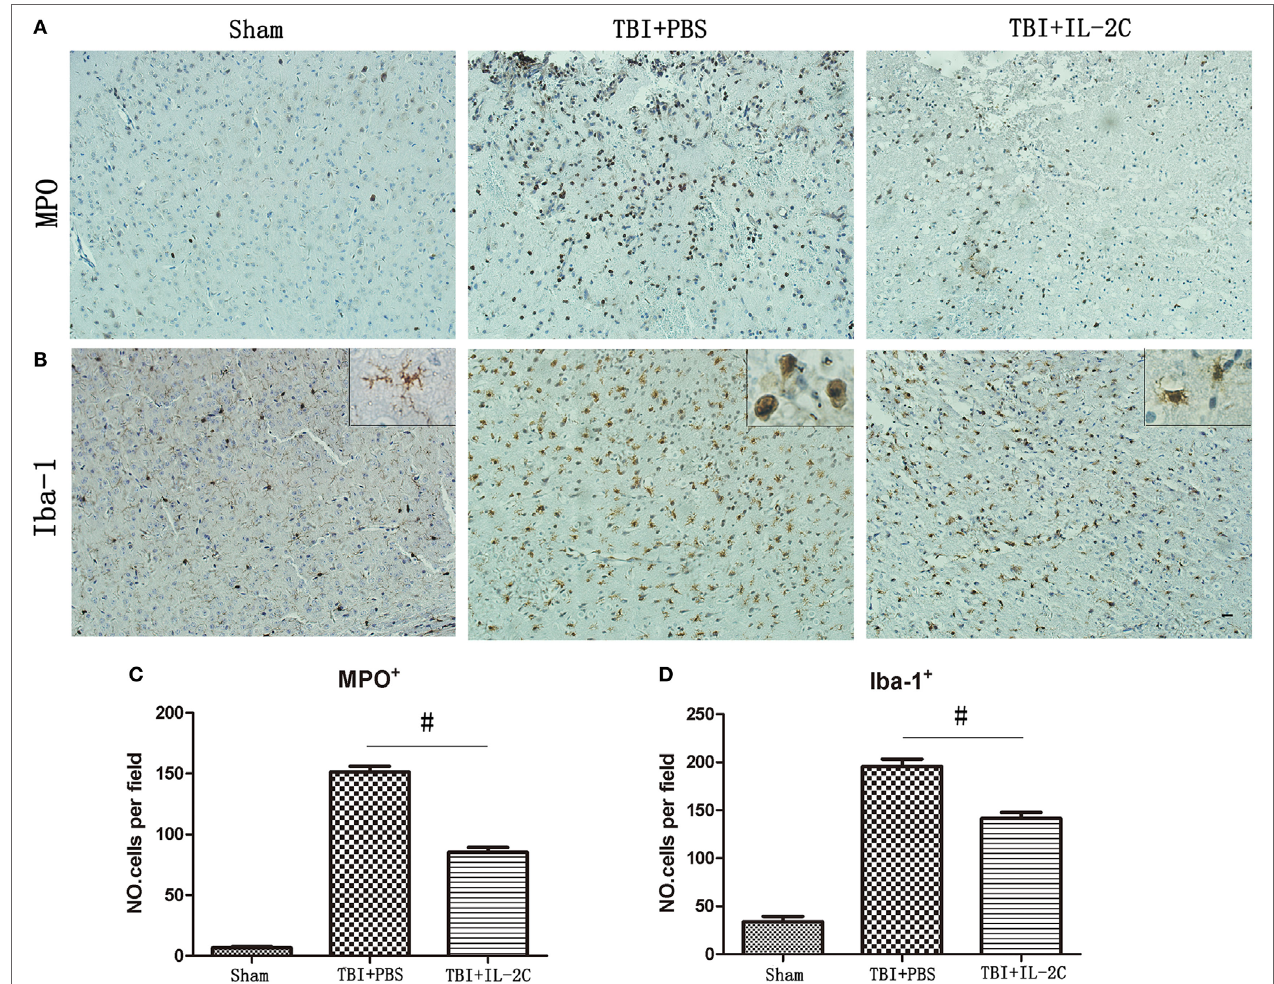
FigUre 9 | (a,c) IL-2C administration significantly reduced infiltration of neutrophils in the brain at day 3 after traumatic brain injury (TBI) ( n = 5 mice/group). (B,D) Treatment with IL-2C resulted in significantly fewer activated microglia in the cortical contusion margin on day 3 post-injury ( n = 5 mice/group). And morphological observation showed that TBI provoked a drastic change in the morphology of microglia from the elongated and ramified shape to a round and enlarged appearance. And treatment with IL-2C significantly reduced the soma size and ramification index. Data are presented as the mean ± SD; * p < 0.05 and # p <